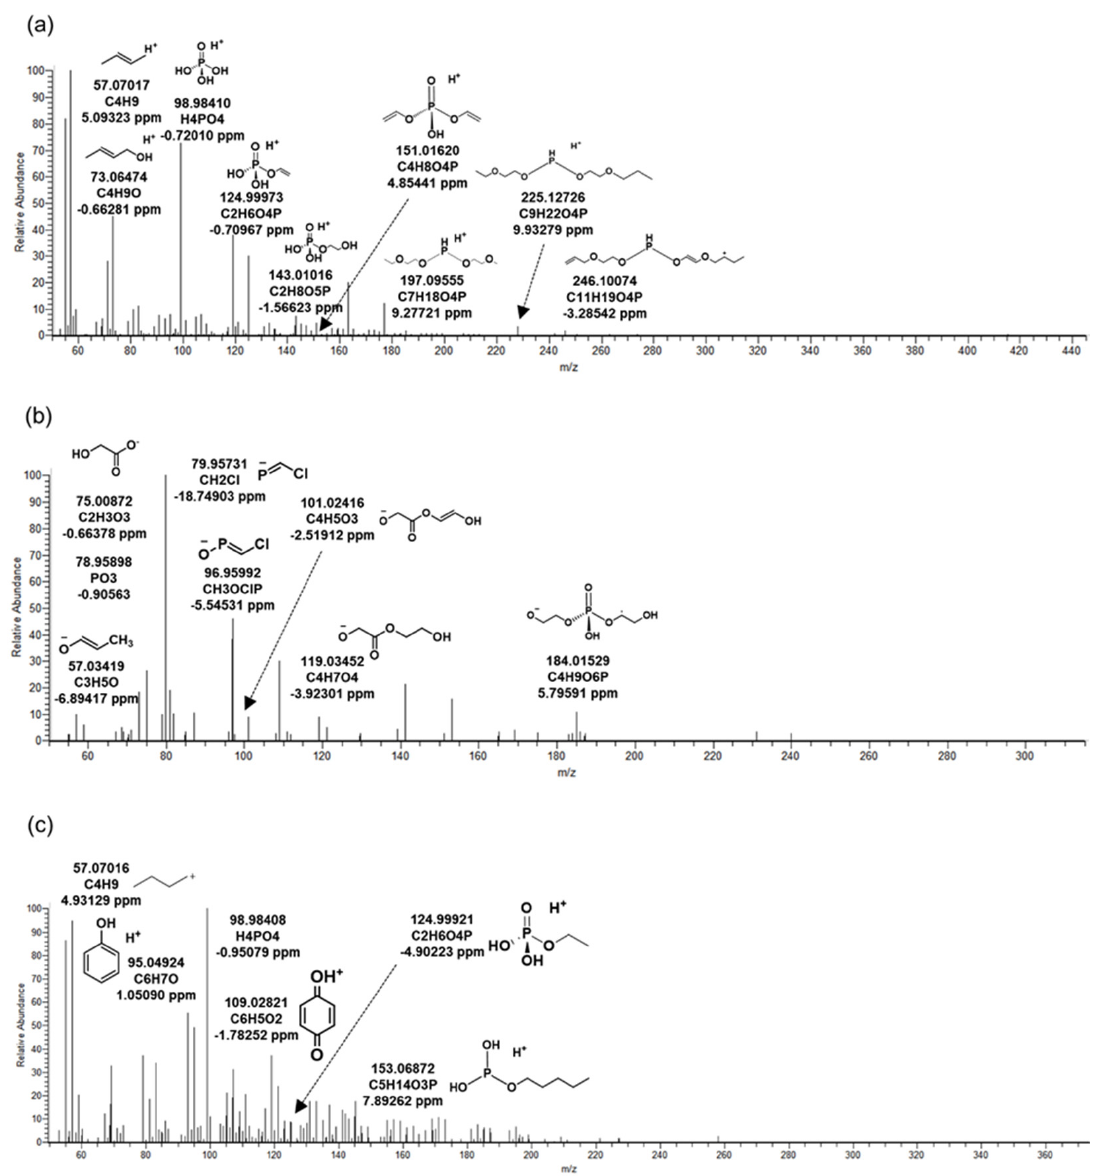
Figure 1. MS/MS fragments at oxidative biotransformation products of organophosphate flame retardants generated in biological reactor from wastewater treatment plant. ( a ) TB_414: biotransformation product (BTP) of tris (2-butoxyethyl) phosphate, ( b ) TC_290: BTP of tris (1-chloro-2-propyl) phosphate, ( c ) TP_342: BTP of triphenyl phosphate.